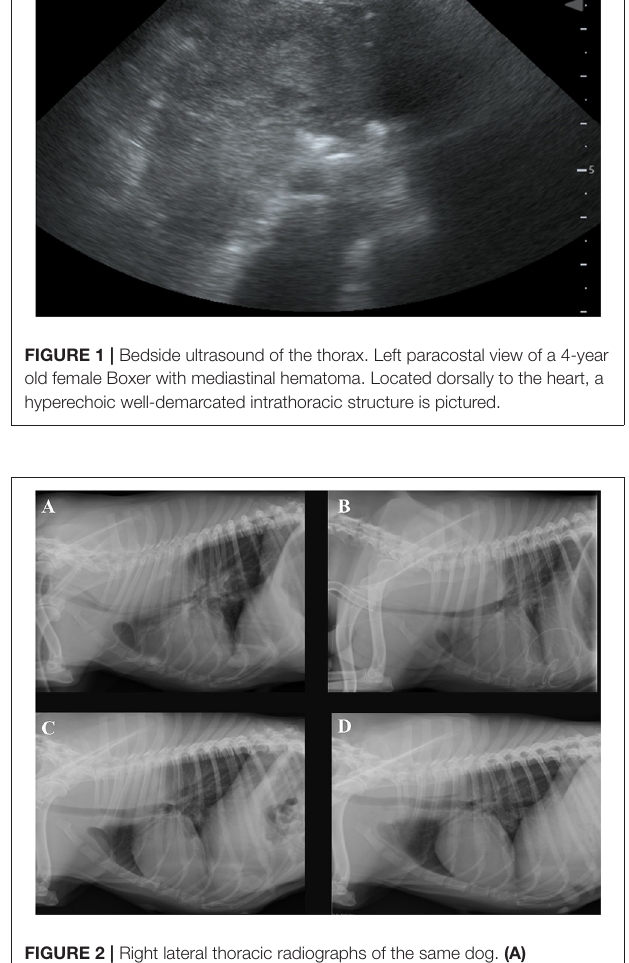
FIGURE 2 | Right lateral thoracic radiographs of the same dog. (A) Radiograph obtained on day 6 of hospitalization, 4h after removing the dialysis catheter, (B) obtained on day 11, (C) on day 16, and (D) on day 23. A soft tissue mass dorsally of the trachea inside the mediastinum is present. Progressive shrinking of the mass to its disappearance through the days of hospitalization can be